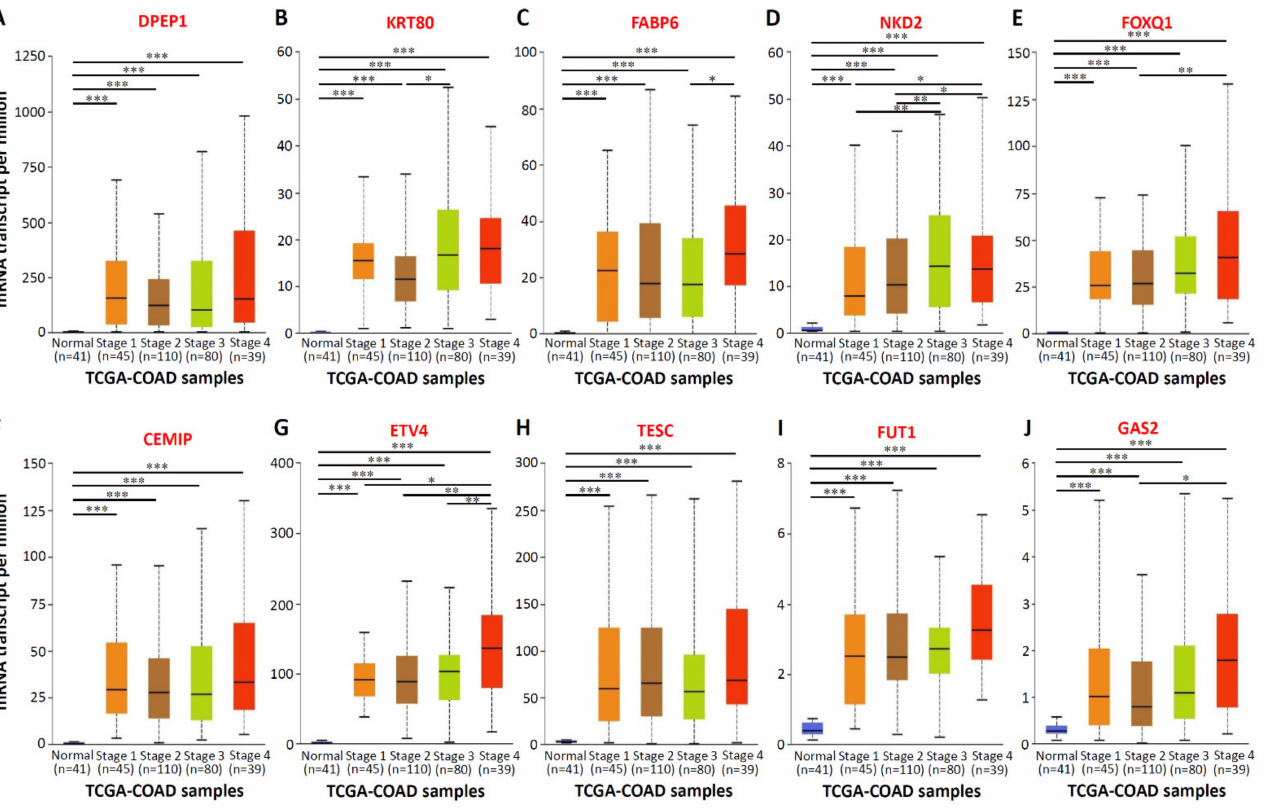
Figure 3. The relationship between mRNA expressions of the top 10 upregulated CRC-associated genes and the individual cancer stages. Individual cancer stages from 274 TCGA-colon adenocarcinoma (COAD) samples include stage 1 to stage 4. The figure presented in ( A – J ) to show the mRNA expressions of 10 upregulated CRC-associated genes changed across all the tumor stages of COAD samples. * p < 0.05, ** p < 0.01, *** p <